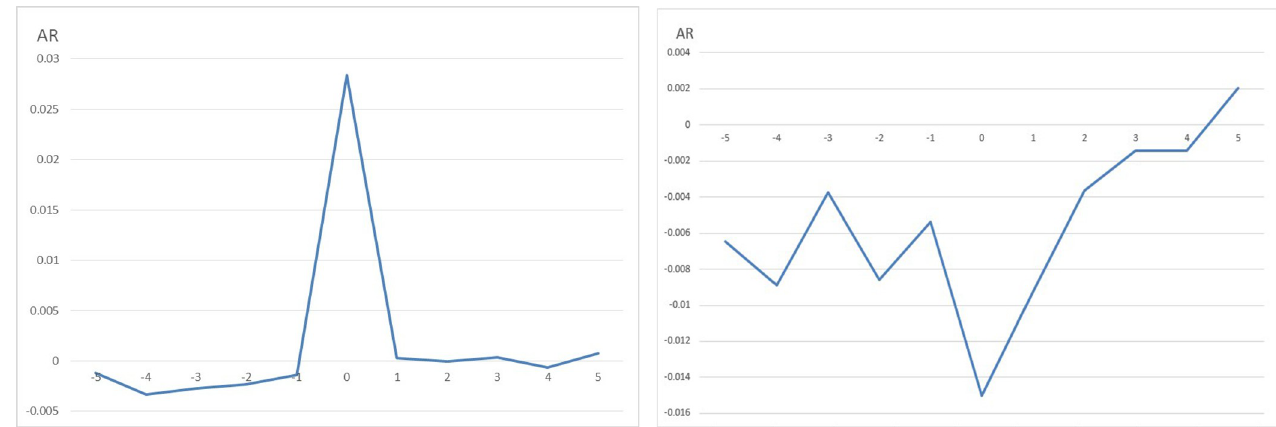
Fig 1. (a) Abnormal returns of positive unanticipated earnings during a window period. (b) Abnormal returns of negative unanticipated earnings during a window